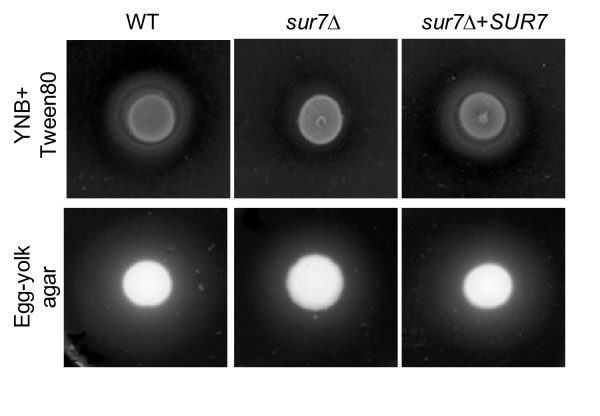
Extracellular lipolytic activity of the C. albicans sur7Δ null mutant. Overnight cultures were spotted onto YNB-Tween 80 and Egg-yolk agar plates and incubated at 37°C. The relative amount of lipolytic and phospholytic degradation is indicated by the halo of precipitation surrounding the fungal colony. Phospholipases and lipases are active on Egg-yolk agar medium whereas only lipases are active on YNB-Tween 80 agar medium [28].